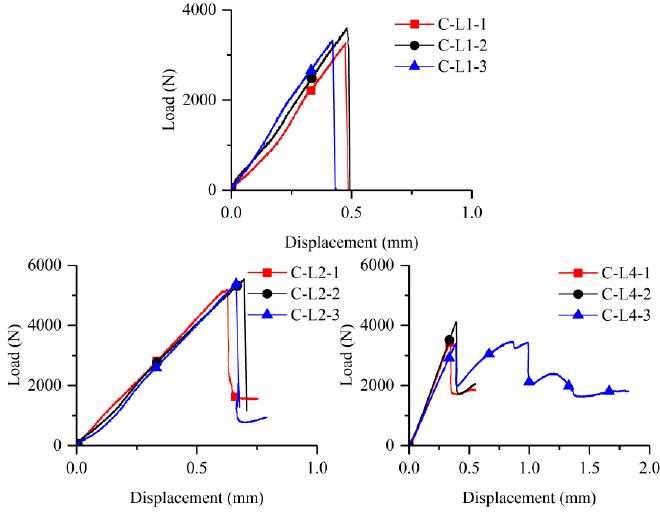
Figure 7. Load-applied displacement curves of BTRC specimens.